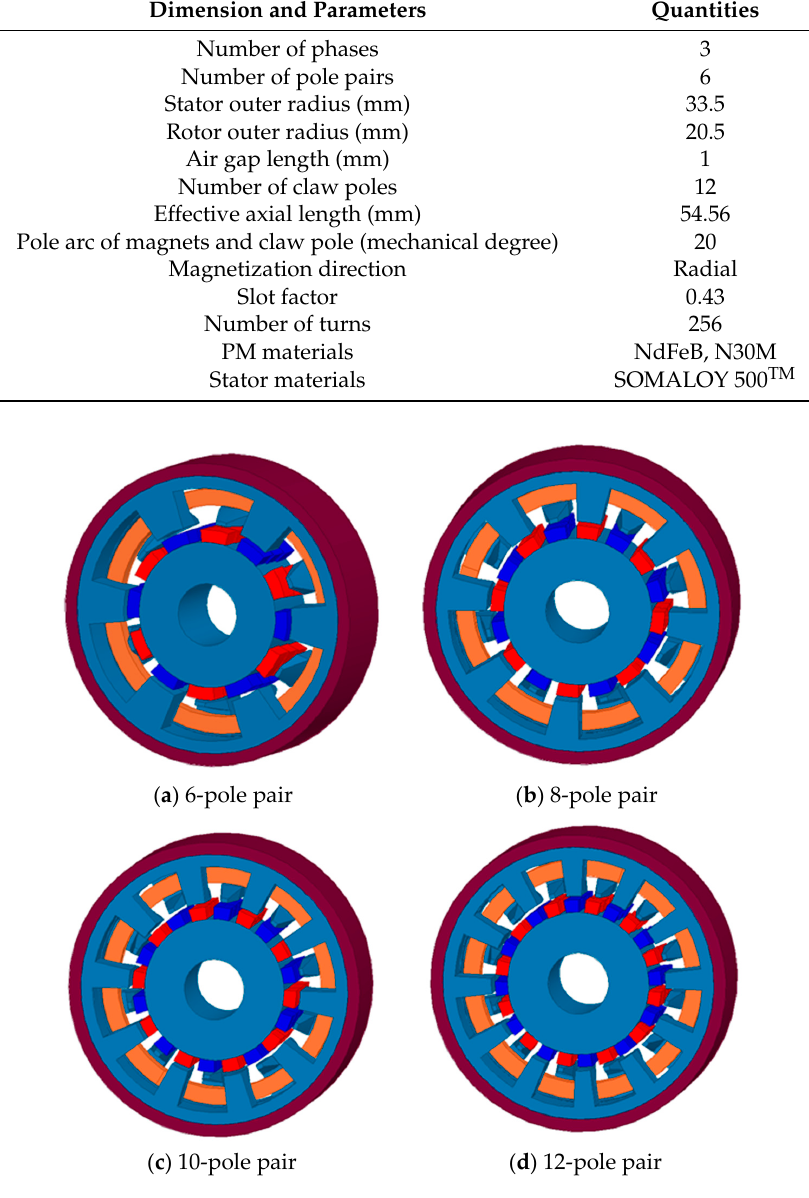
( a ) Main parameter and dimension of CPM ( b ) Mesh of CPM ( c ) Noload flux density distribution of CPM Figure 3. Main parameter and dimension, mesh and no load flux density distribution of a claw pole machine (CPM). 3. Torque Equation Deduction The electromagnetic power of the CPM can be expressed as: ( ) ( )0 22 sin(